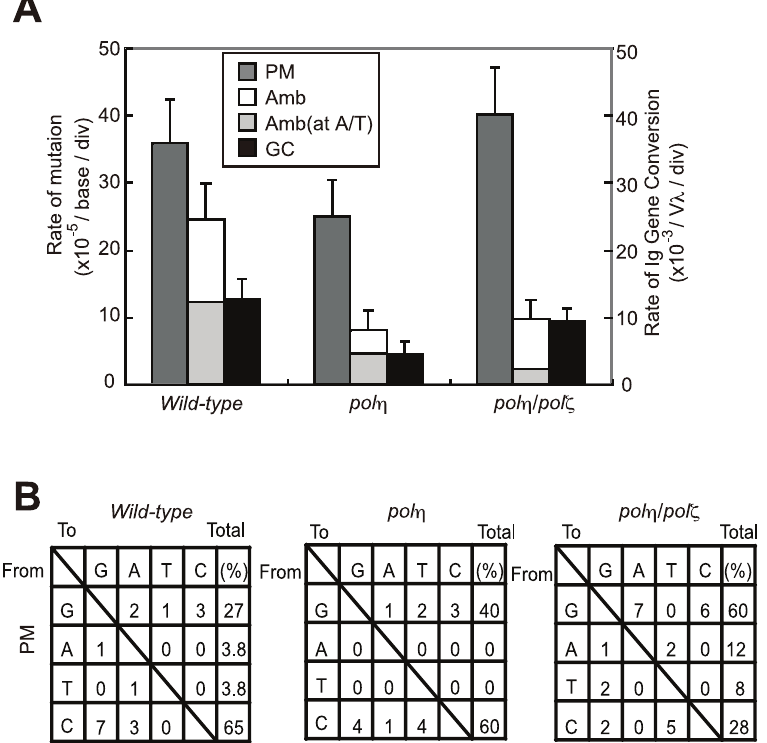
Figure 4. TLS–dependent point mutations in Ig V occur with comparable frequency in wild-type and pol g /pol f cells. (A) Rate of non- templated single-base substitutions (PM), ambiguous single base substitutions (Amb) (which are single base changes that have a potential donor sequence in the pseudogene array), and bona fide gene conversion tracts (GC) in the AID-virus-infected wild-type , pol g , and pol g /pol f DT40 cells shown in Figure 3. Cells were clonally expanded for two weeks. Three clones were analyzed in each data set. Note that the Amb mutation at A/T pairs represents short-tract gene conversion [32]. (B) Nucleotide substitution preferences (as a percentage of the indicated number in the total mutations) deduced from the V l sequence analysis of the clones shown in (A). The preferences are shown for mutations categorized as non-templated base substitutions (PM), which are caused by TLS past abasic sites [32].